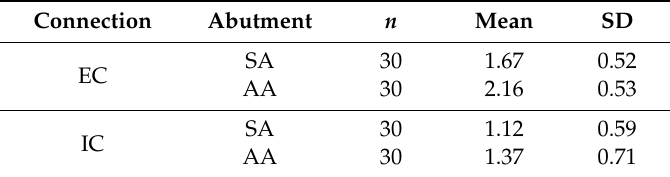
Table 6. Means and standard deviation (SD) misfit values (micrometers) for connections and abutments regardless of torque load (EC: external connection; IC: internal connection; SA: straight abutment; AA: angulated abutment).